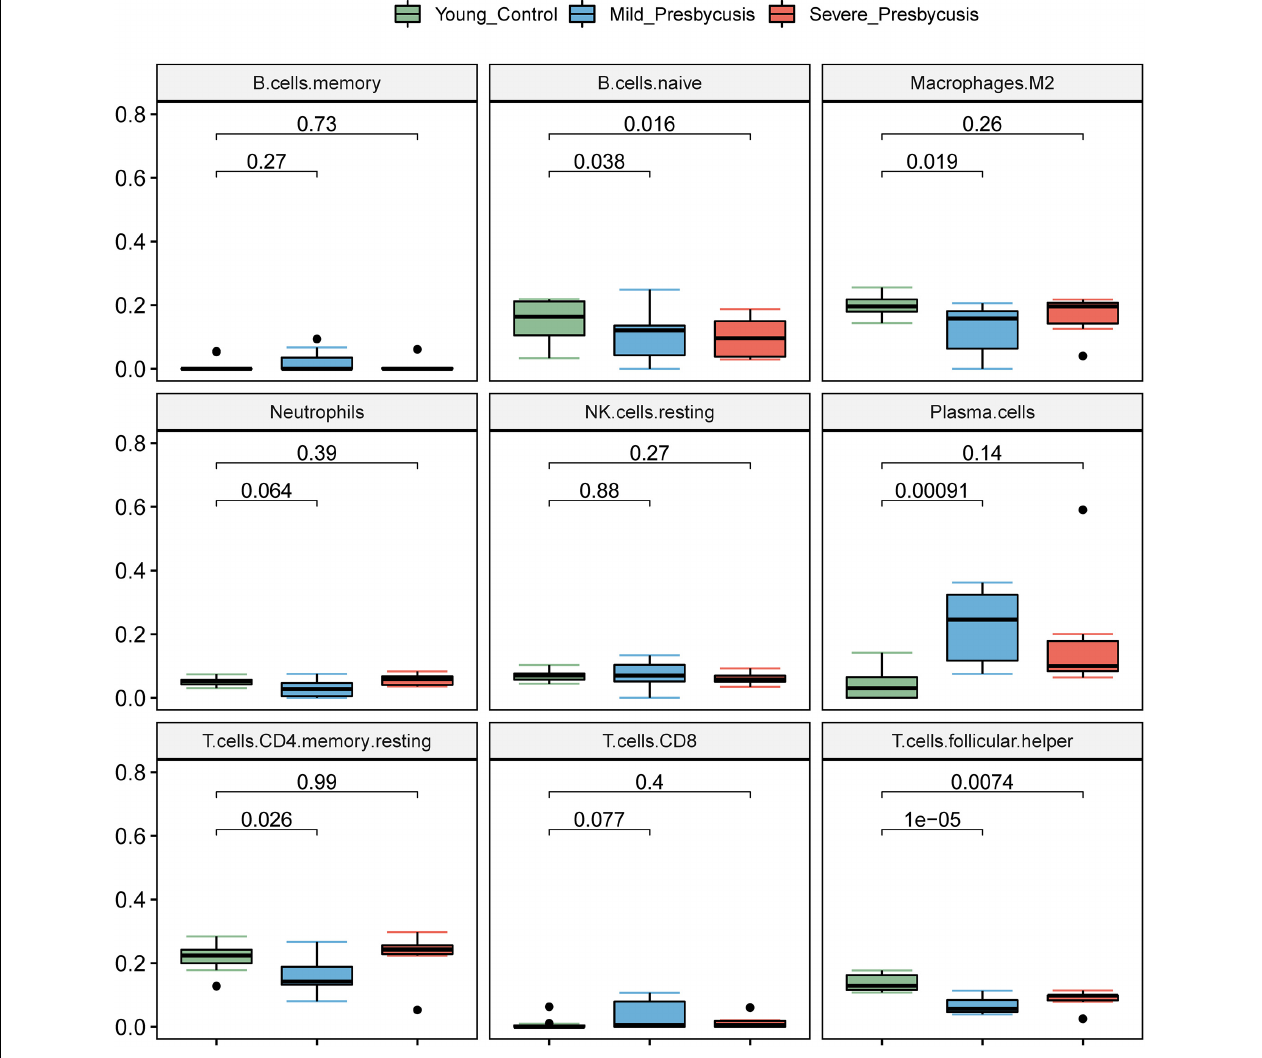
FIGURE 7 | The relationship between hearing loss degree and immune infiltration. The differential expression of the immune cells between each presbycusis group and control group is shown.